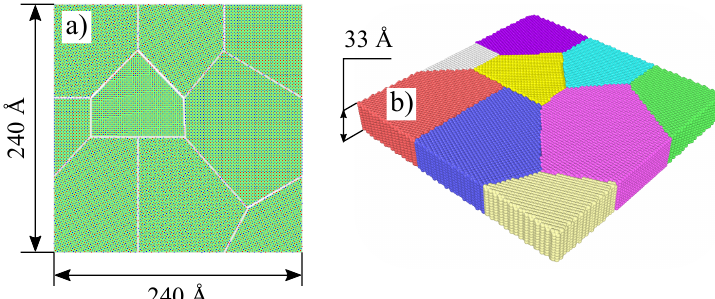
Figure 1. Initial grain configuration of the MD simulation model. ( a ) The front view and ( b ) the three-dimensional view of the model. Each different color represents a different